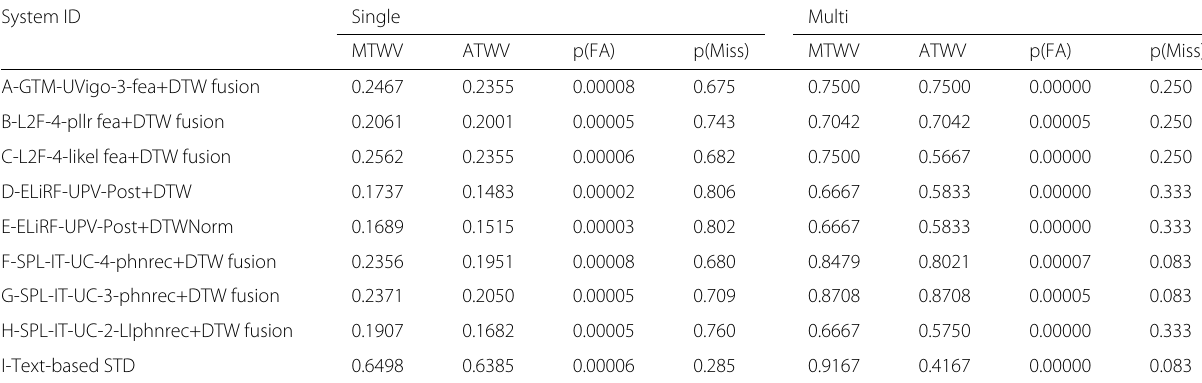
Table 15 System results of the ALBAYZIN QbE STD 2016 evaluation on the MAVIR test data for the single-word (‘Single’) and the multi-word (‘Multi’)